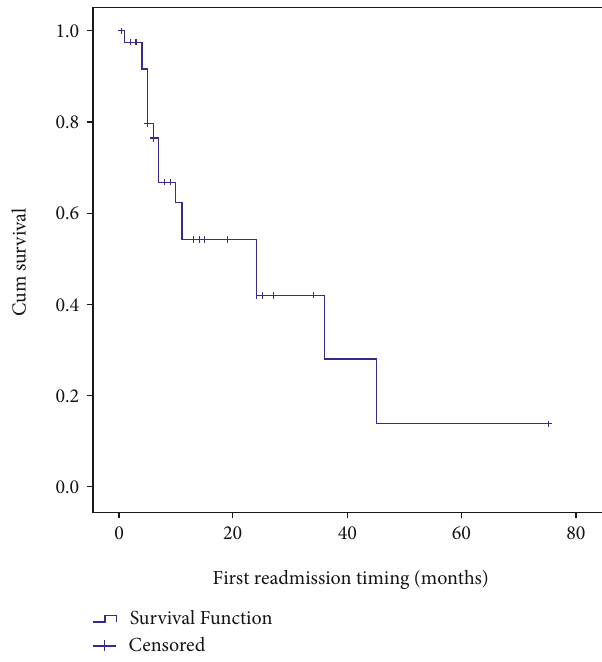
Figure 6: Probability of remaining free from hospital readmission for a new episode of AHRF during the study follow-up